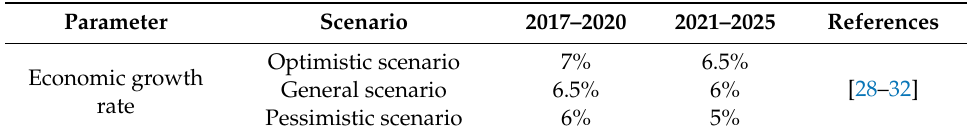
Table 1. Estimated national economic growth rate during